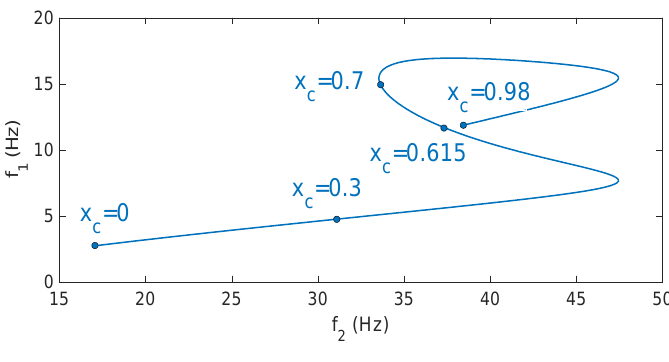
Figure 9. Sensing curve f 2 - f 1